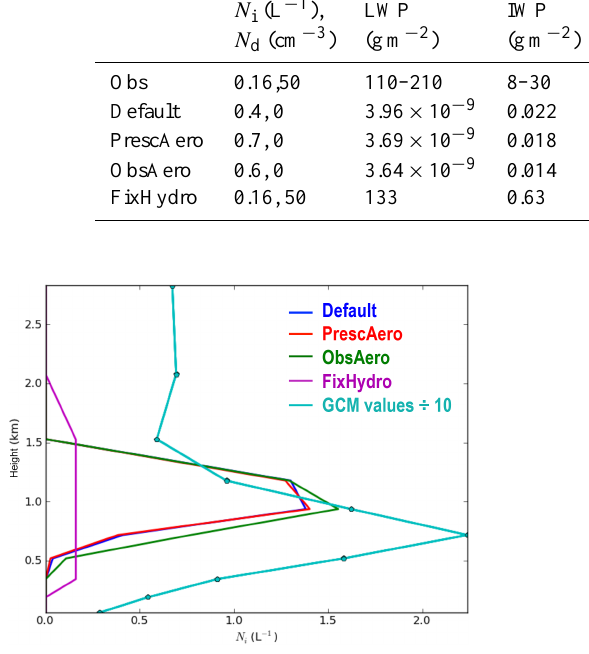
Figure 5. Time-averaged profiles of cloud fraction from models and observations as a function of height during the MPACE-B period. All observations are taken from K09.